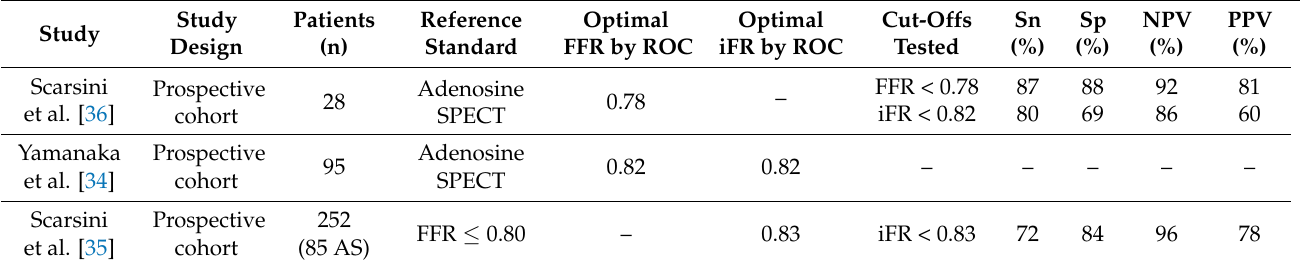
Table 2. Invasive assessment of myocardial ischemia in patients undergoing